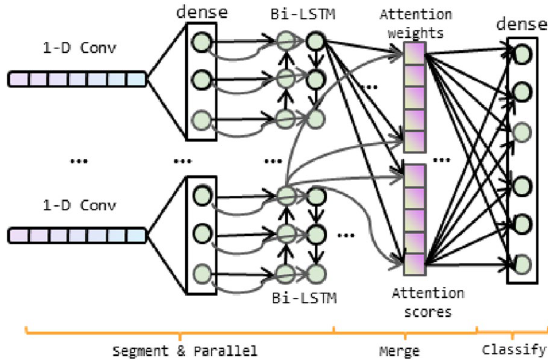
Figure 1. The block diagram of the proposed methodology.